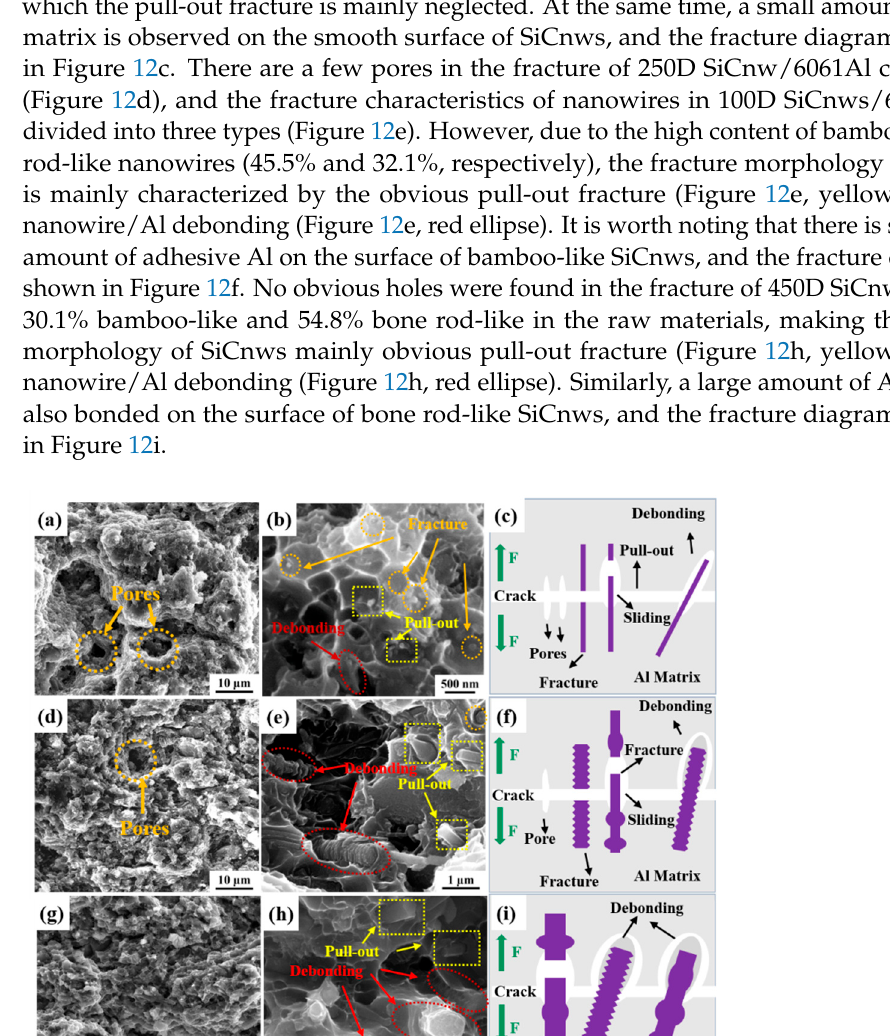
9 of 13 three characteristics: negligible pull-out fracture (Figure 12b, orange circle), obvious pull- out fracture (Figure 12b, yellow box) and nanowire/Al debonding (Figure 12b, red oval), in which the pull-out fracture is mainly neglected. At the same time, a small amount of the Al matrix is observed on the smooth surface of SiCnws, and the fracture diagram is shown in Figure 12c. There are a few pores in the fracture of 250D SiCnw/6061Al compo- sites (Figure 12d), and the fracture characteristics of nanowires in 100D SiCnws/6061Al are divided into three types (Figure 12e). However, due to the high content of bamboo- like and rod-like nanowires (45.5% and 32.1%, respectively), the fracture morphology of